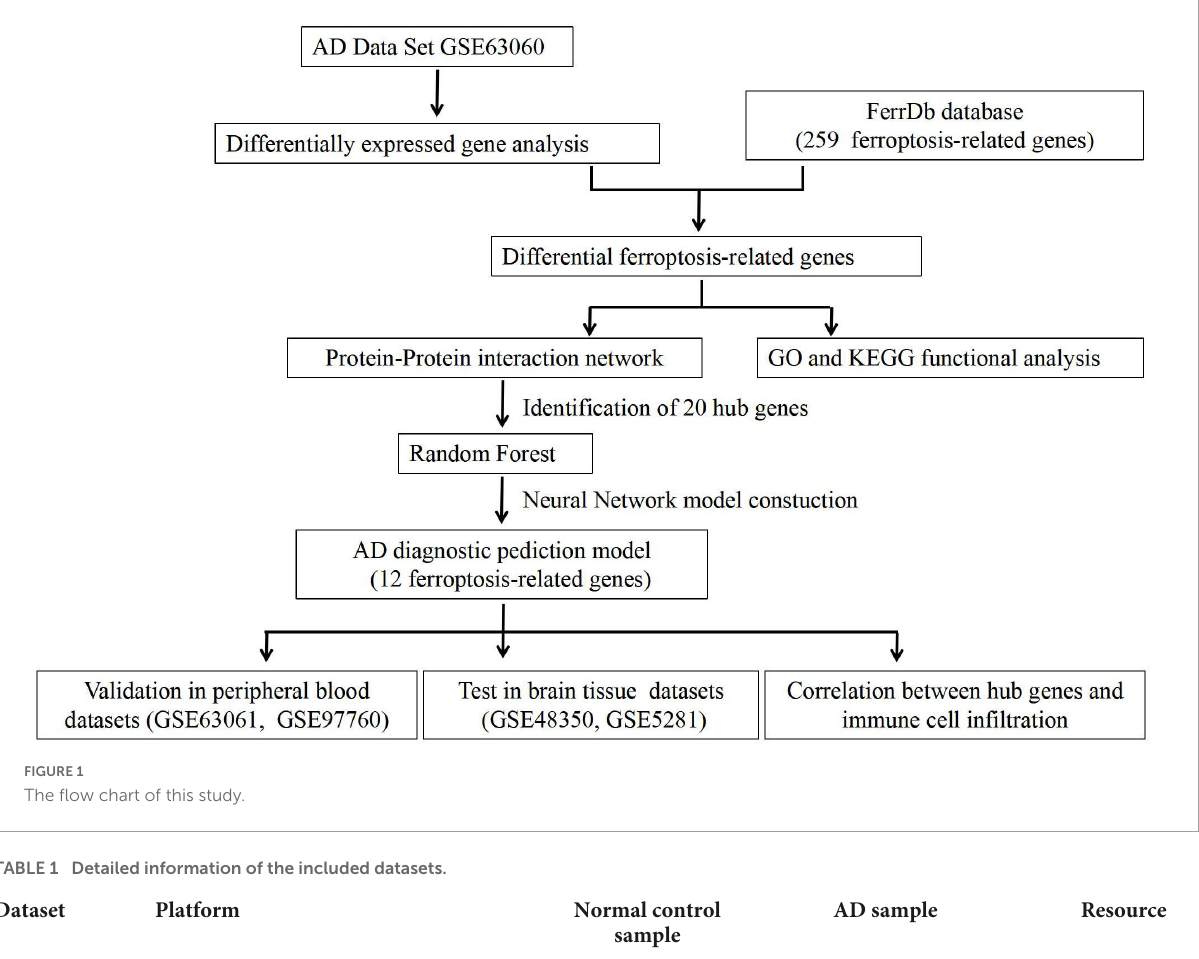
TABLE 1 Detailed information of the included